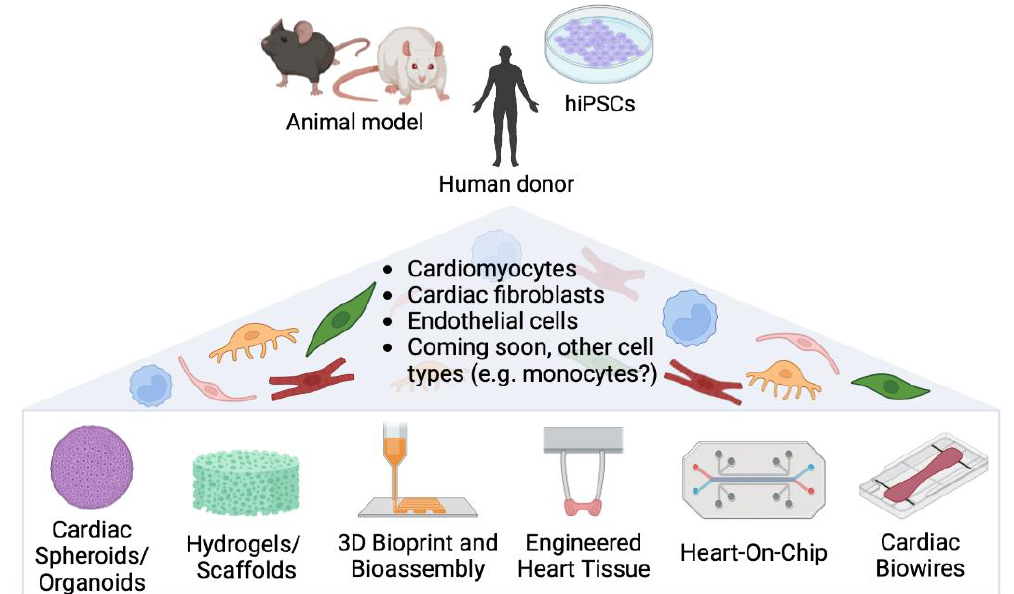
Figure 2. Multicellular 3D modelling systems of the cardiac microenvironment. Multiple cardiac cell types can be obtained from the tissue of animal models, human donors, or from differentiation of human induced pluripotent stem cells (hiPSCs). Multiple setups are depicted allowing culture in three dimensions to recapitulate the complex cardiac microenvironment. This figure was created with Biorender software.